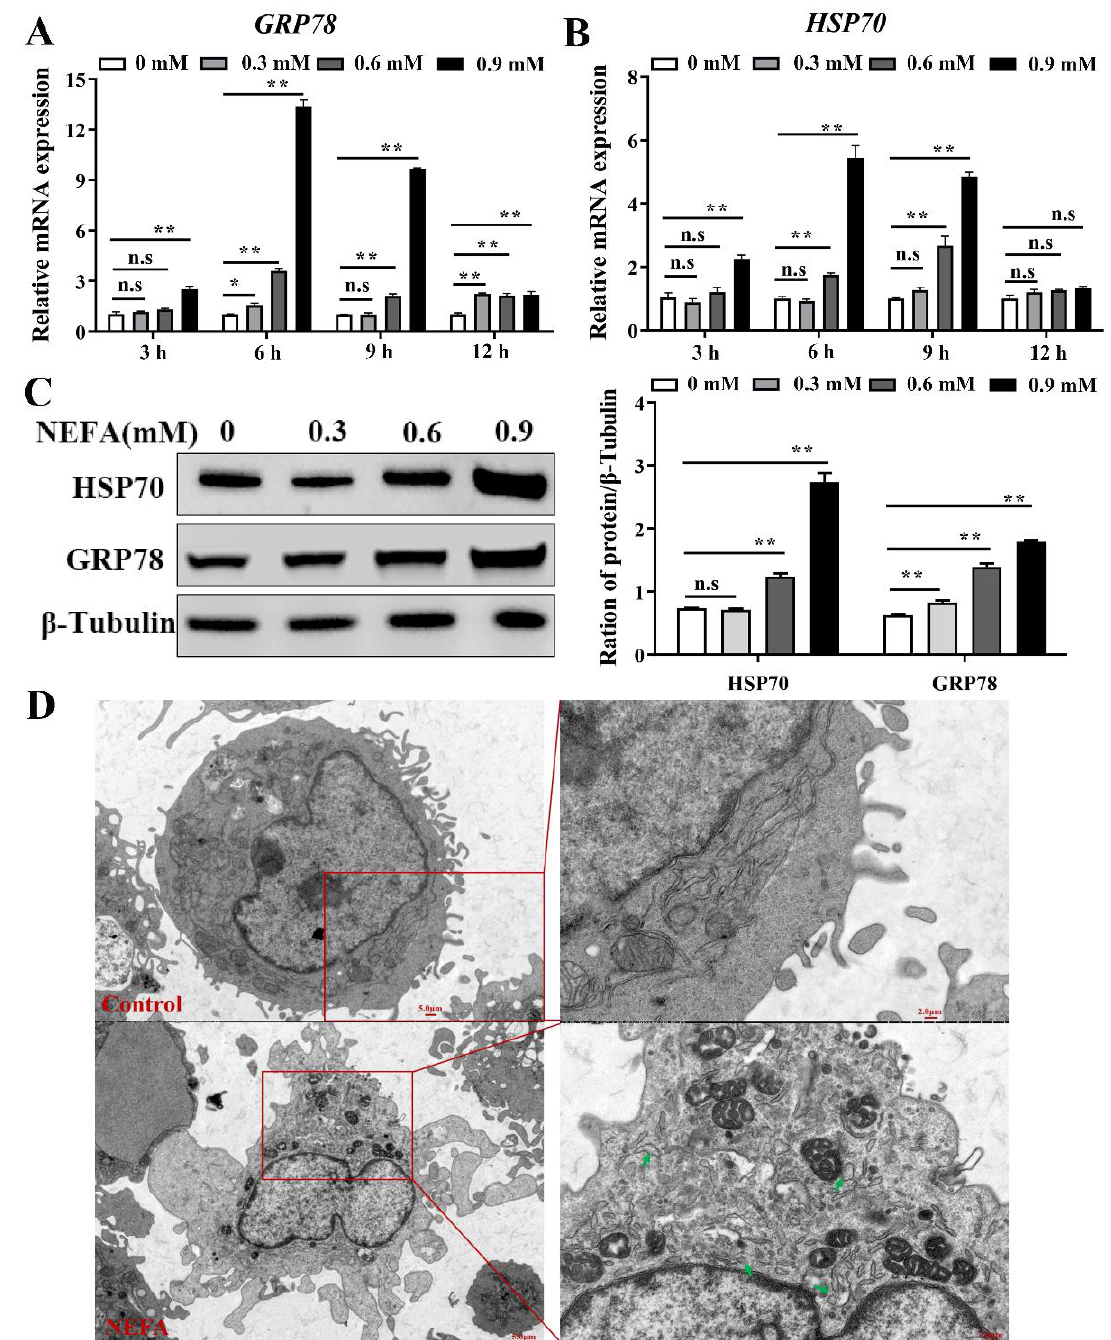
Figure 1. NEFA induced ER stress in bovine mammary epithelial cells. ( A , B ) Relative mRNA expression of GRP78 and HSP70 in BMECs after treatment with various concentrations (0.3, 0.6, and 0.9 mM) of NEFA for 3, 6, 9, and 12 h. ( C ) Protein expression of GRP78 and HSP70 in BMECs stimulated with the different concentrations of NEFA for 6 h. ( D ) TEM images of BMECs in the absence and presence of 0.9 mM NEFA for 6 h; green arrowheads represent ER expansion. Data are presented as the means ± the standard errors of the mean (SEM) of three independent experiments. n.s. means not significant, * p < 0.05; ** p < 0.01.